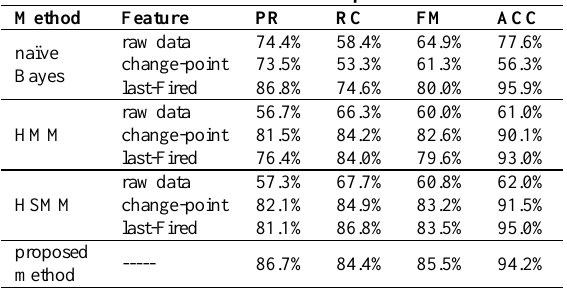
Table 10. The results of experiment